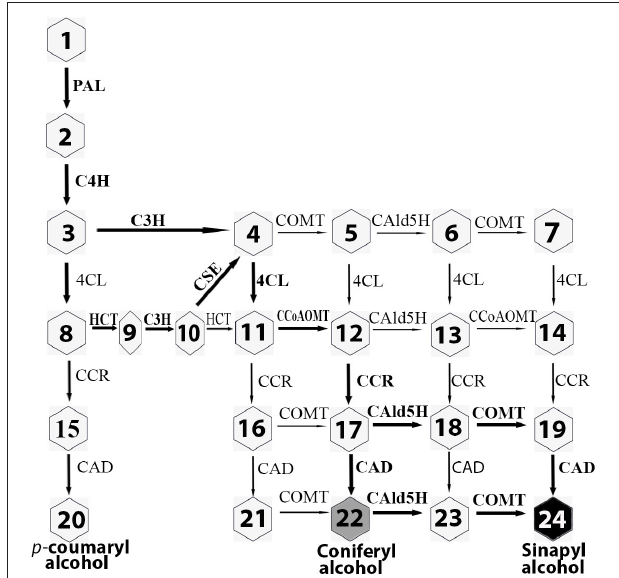
FIGURE 1 | Monolignol biosynthetic pathway in poplar. Bold arrows indicate the main metabolic flux. Eleven enzyme families are PAL, phenylalanine ammonia-lyase; C4H, cinnamate 4-hydroxylase; C3H, p -coumaroyl-CoA 3-hydroxylase; 4CL, p -coumarate CoA ligase; HCT, hydroxycinnamoyltransferase; CSE, caffeoyl shikimate esterase; CCoAOMT, caffeoyl-CoA O -methyltransferase; CCR, cinnamoyl-CoA reductase; CAld5H, coniferaldehyde 5-hydroxylase; COMT, caffeic acid 3- O -methyltransferase; CAD, cinnamyl alcohol dehydrogenase. The metabolites are shown